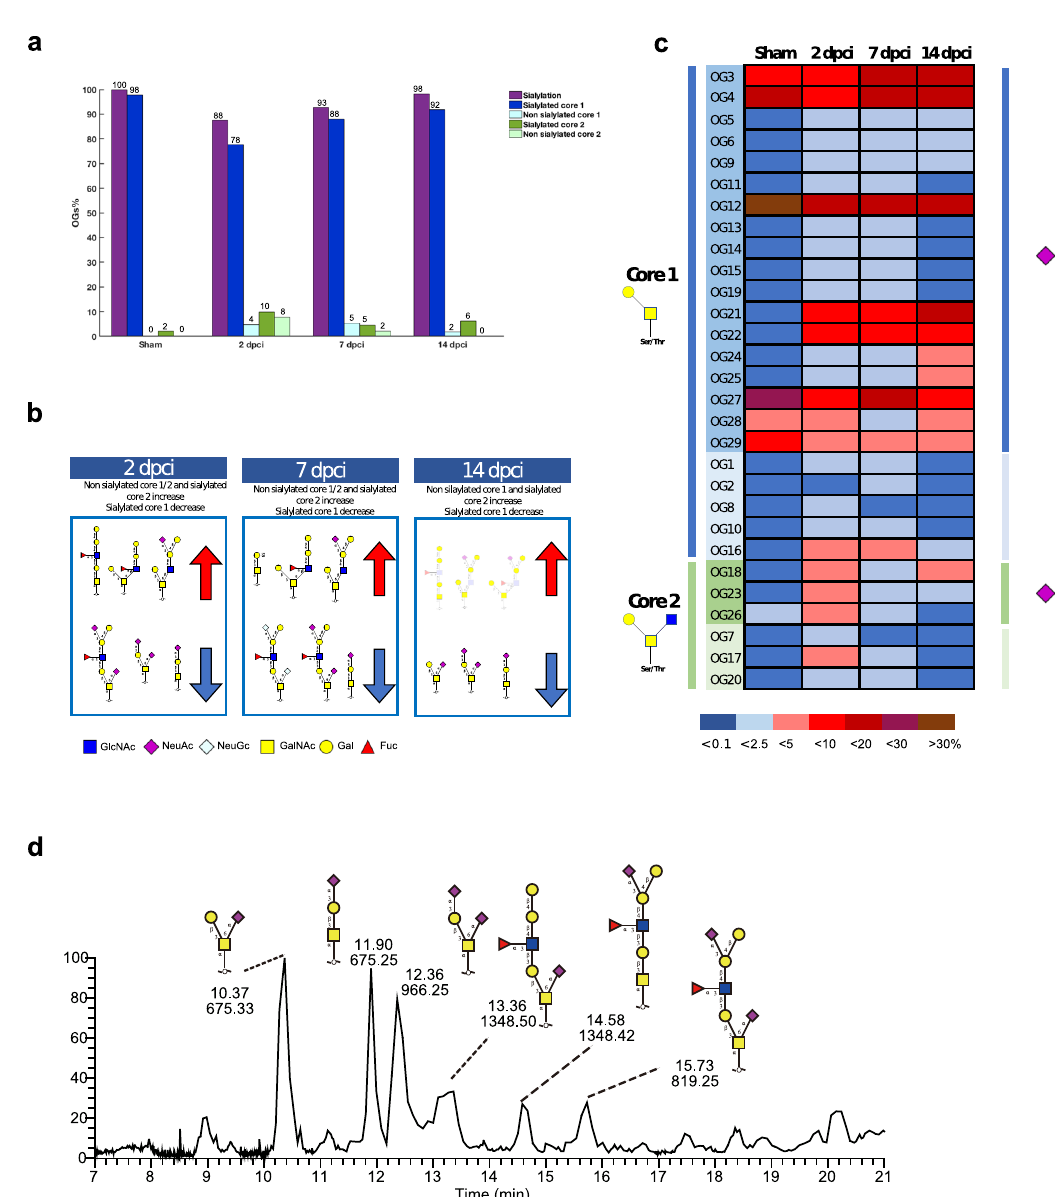
Fig. 6 Membrane O-glycan pro fi le of regenerating zebra fi sh heart established by LC-MS/MS revealed decreased sialylation during the in fl ammatory phase. a Comparison of O-glycan structures (core 1 and core 2) and sialylation between sham and the different regeneration phases (2, 7 and 14 dpci). The in fl ammatory phase (2 dpci) showed a 12% decrease in sialylated O-glycans and a subsequent increase at 7 and 14 dpci. b Summary of the main changes in O-glycan structures (sialylated core 1/2 increase/decrease, non-sialylated core 1/2 increase/decrease) showing some of the corresponding structures. c Heatmap displaying time-speci fi c relative quanti fi cation of core 1 and core 2 O-glycans. Sialylated structures are also indicated (purple square). Color intensity represents the relative abundance expressed as a percentage. d EIC showing the most abundant membrane O-glycans present in zebra fi sh heart. Results deriving from samples from the pooling of six animals are shown ( n = 6 animals per